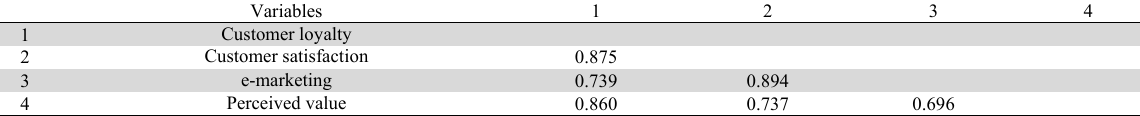
HTMT Ratio Analysis